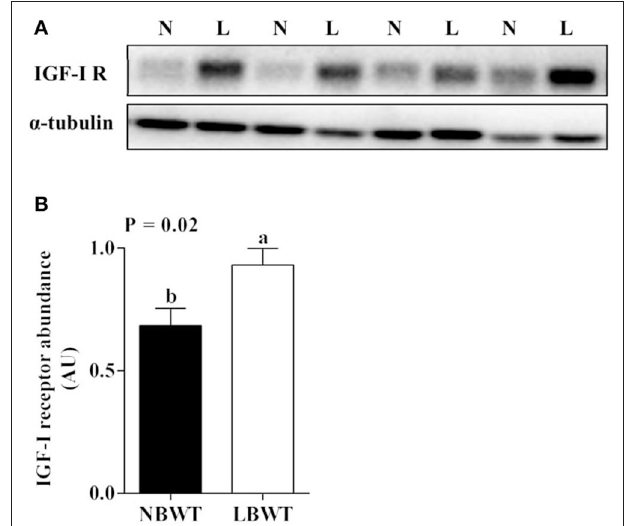
FIGURE 3 | Protein abundance of IGF-I receptor (IGF-I R) in longissimus dorsi muscle of low-birth-weight (LBWT) and normal-birth-weight (NBWT) neonatal pigs. (A) : Representative western blot images from four pairs of NBWT and LBWT pigs (N, NBWT; L, LBWT). (B) : Abundance of IGF-I R was normalized to α -tubulin. Results are means ± SE. n = 12. Values with different letters differ significantly ( P ≤